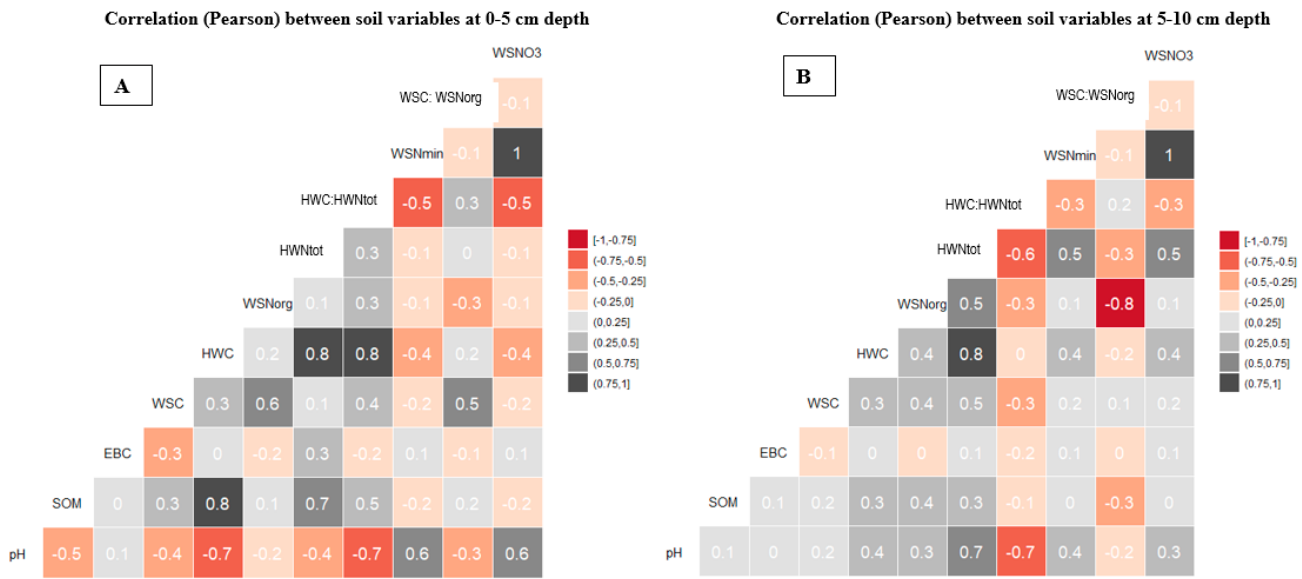
Figure 4. Pearson correlation matrices showing the relationship between soil properties and water-extractable C and N fractions in the upper (( A ) 0–5 cm) and lower (( B ) 5–10 cm) soil layers. Relationships between parameters are indicated by the values at the intersection of parameters and interpreted within color contrast as shown in the legends.